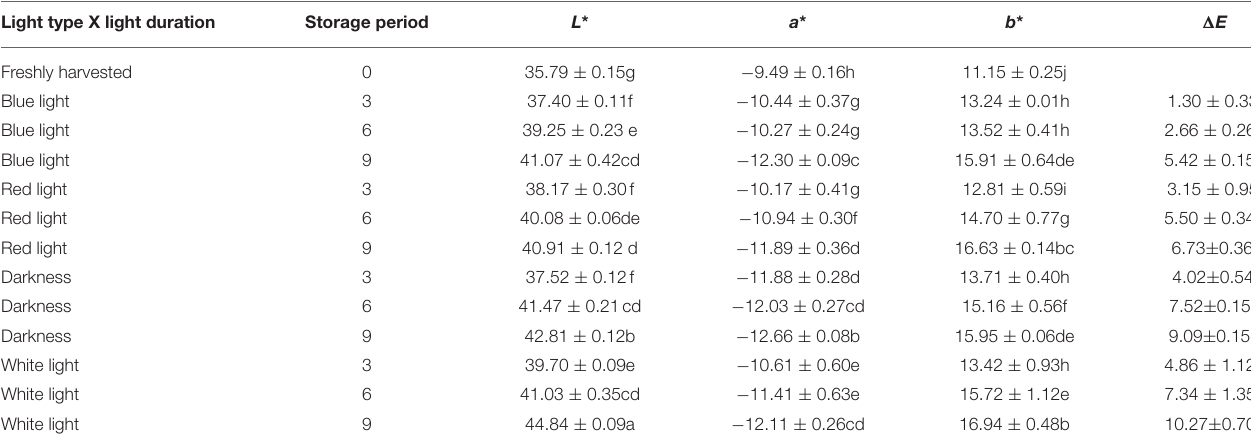
TABLE 1 | Influence of blue and red light-emitting diode (LED) lights for 2 h during storage on colour changes of coriander ( Coriandrum sativum ) leaves. Light type X light